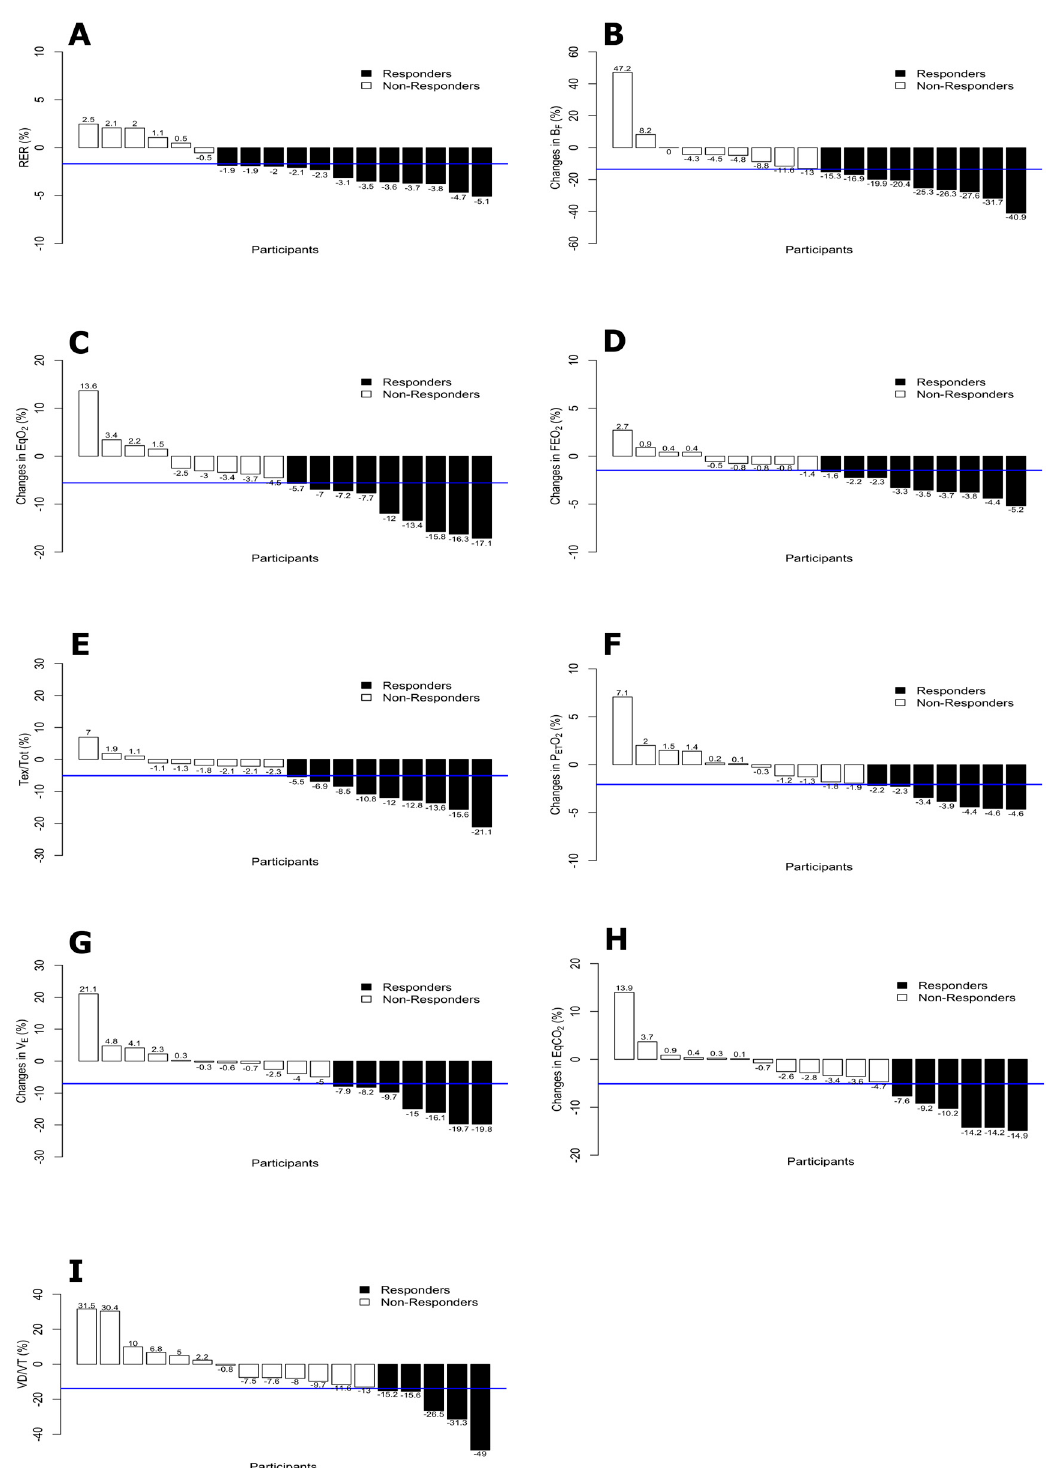
Figure 5. Percentage of change by participants and TE for ONB > FB group variables: RER ( A ), B F ( B ), EqO 2 ( C ), FEO 2 ( D ), Tex/Tot ( E ), PETO 2 ( F ), VE( G ), EqCO 2 ( H ) and VD/VT ( I ).